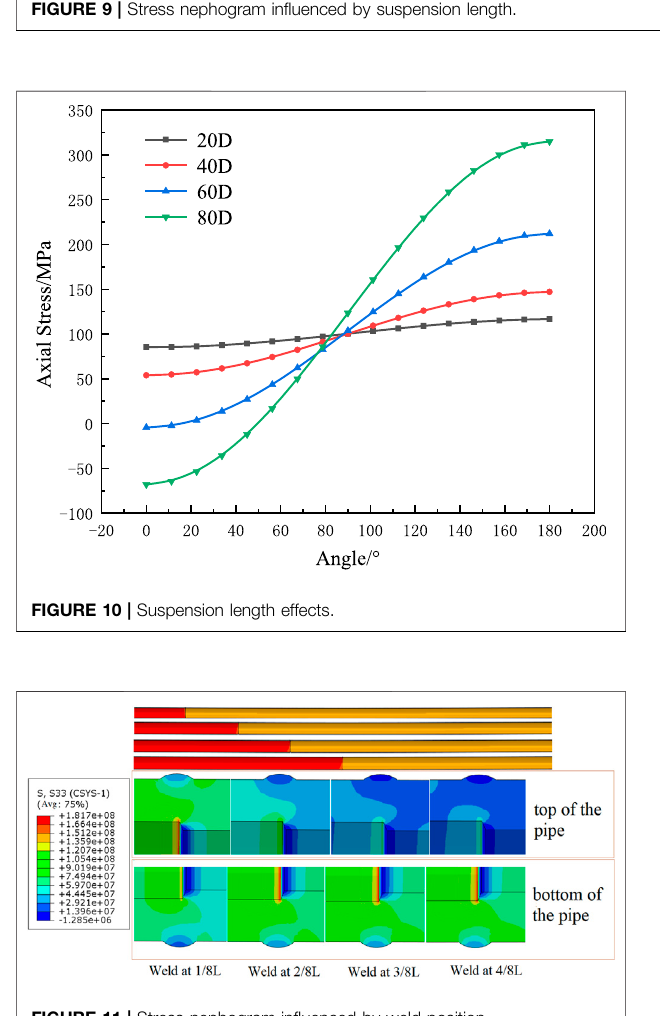
FIGURE 11 | Stress nephogram in fl uenced by weld position.